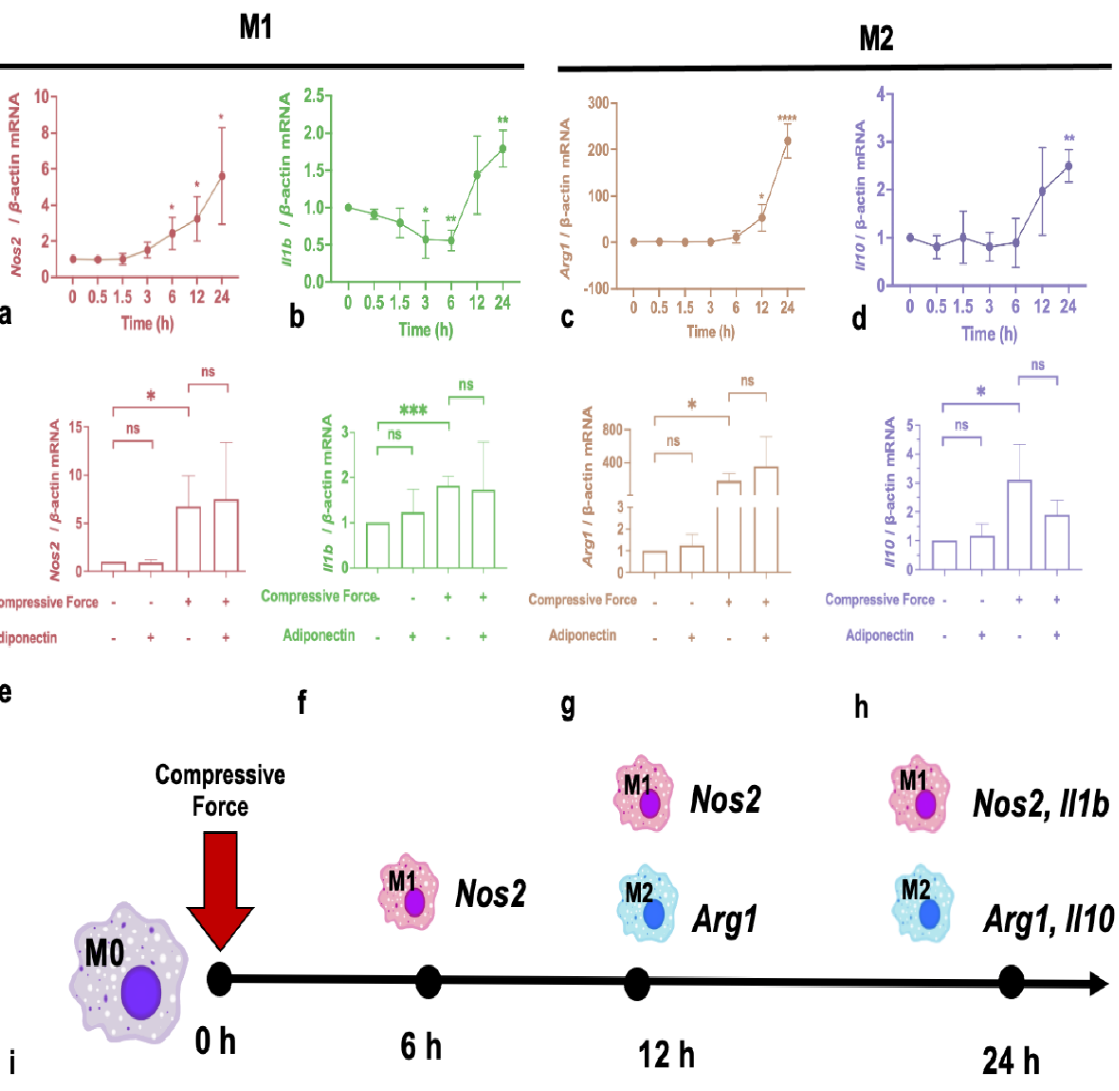
Figure 2. The effects of compressive force on macrophage polarization markers. ( a – d ) Compressive force up-regulated Nos2 , Il1b , Arg1 , and Il10 levels. ( e – h ) Adiponectin did not affect Nos2 , Il1b , Arg1 , and Il10 expression. ( i ) Nos2 increased significantly 6 h after force-loading. Il1b , Arg1 , and Il10 were elevated after 24 h. Values are expressed as means ± SD; ns — not significant; * p < 0.05; ** p < 0.01; *** p < 0.001; **** p <